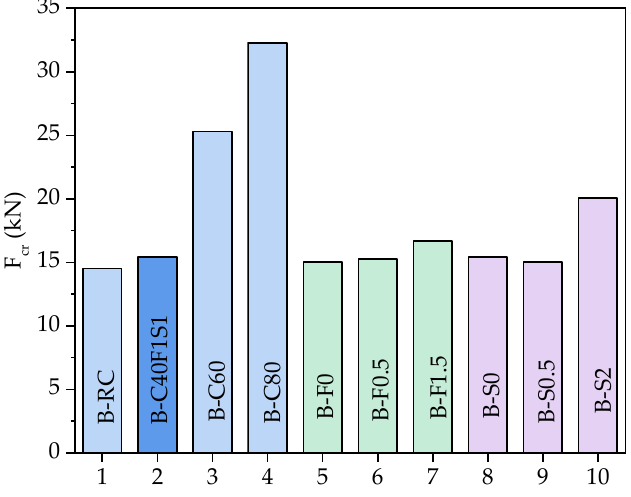
Figure 7. Cracking load of all the tested specimens.